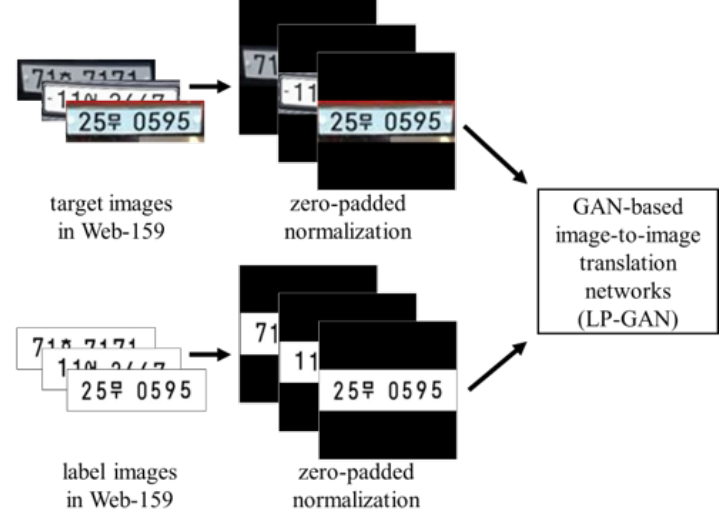
Figure 4. Training of GAN-based image-to-image translation networks.